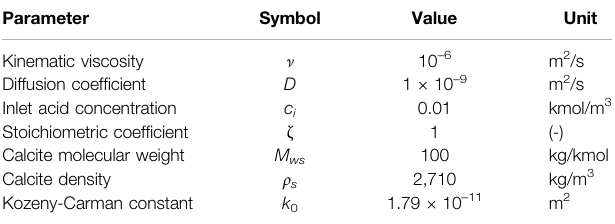
TABLE 3 | Simulation parameters for Benchmark 2.